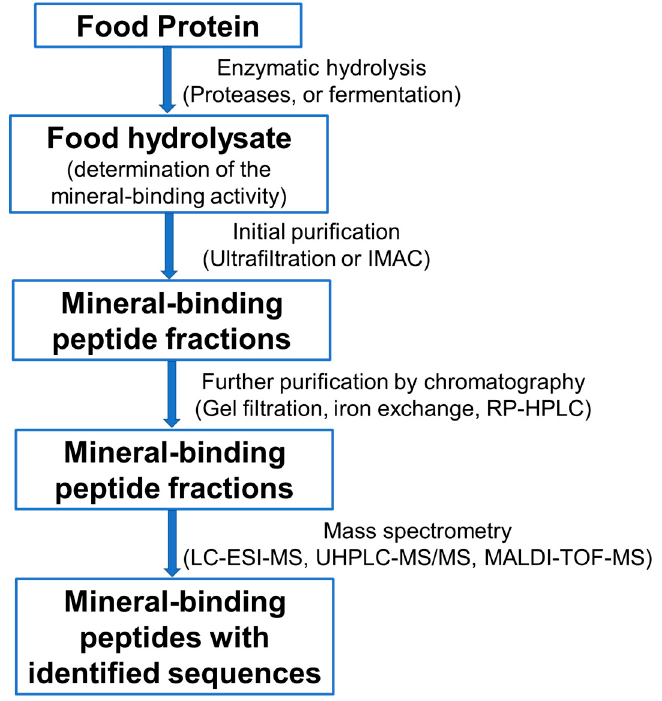
Figure 1. Schematic diagram indicating steps toward the preparation, purification, and identification of mineral-binding peptides from food proteins. IMAC: immobilized metal affinity chromatography; RP-HPLC: reversed-phase high performance liquid chromatography; LC-ESI-MS: liquid chromatography-electrospray ionization mass spectrometry; UHPLC-MS / MS: ultra-high performance liquid chromatography-tandem mass spectrometry; MALDI-TOF-MS: matrix-assisted laser desorption / ionization time-of-flight mass spectrometry.